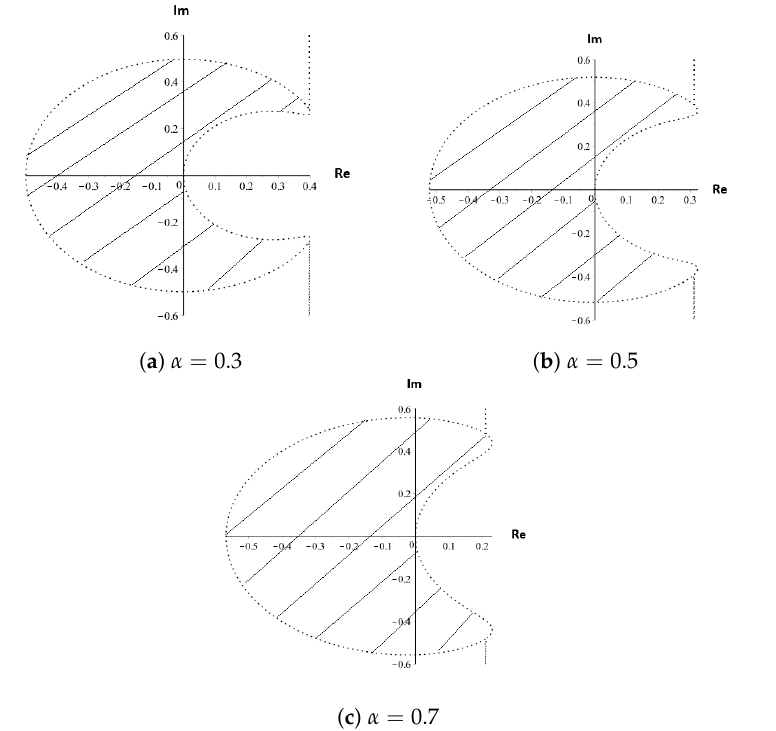
Figure 1. Stability region for FEAM3 when 0 < α < 1.